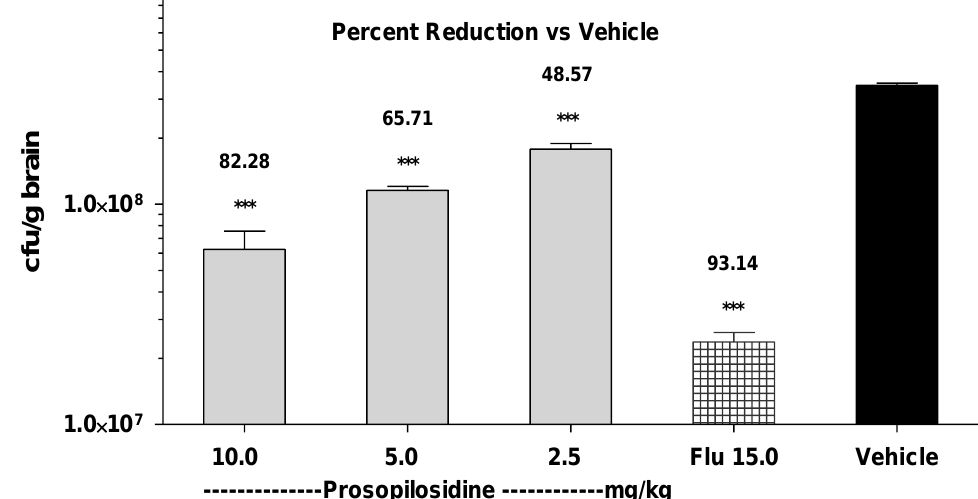
Figure 5. Cryptococcus neoformans infection in mice treated with prosopilosidine given via the oral route. Graph showing live colony forming units (CFU) of C. neoformans per gram of brain tissue and the percent reduction in infection by prosopilosidine treatment given at doses 2.5, 5.0, and 10.0 mg/kg body weight and Fluconazole (Flu) (15 mg/kg body weight) as compared to the vehicle control. Data are shown as mean ± SEM ( n = 5) and was analyzed with ANOVA. *** p < 0.001 was considered significant as compared to the vehicle control.